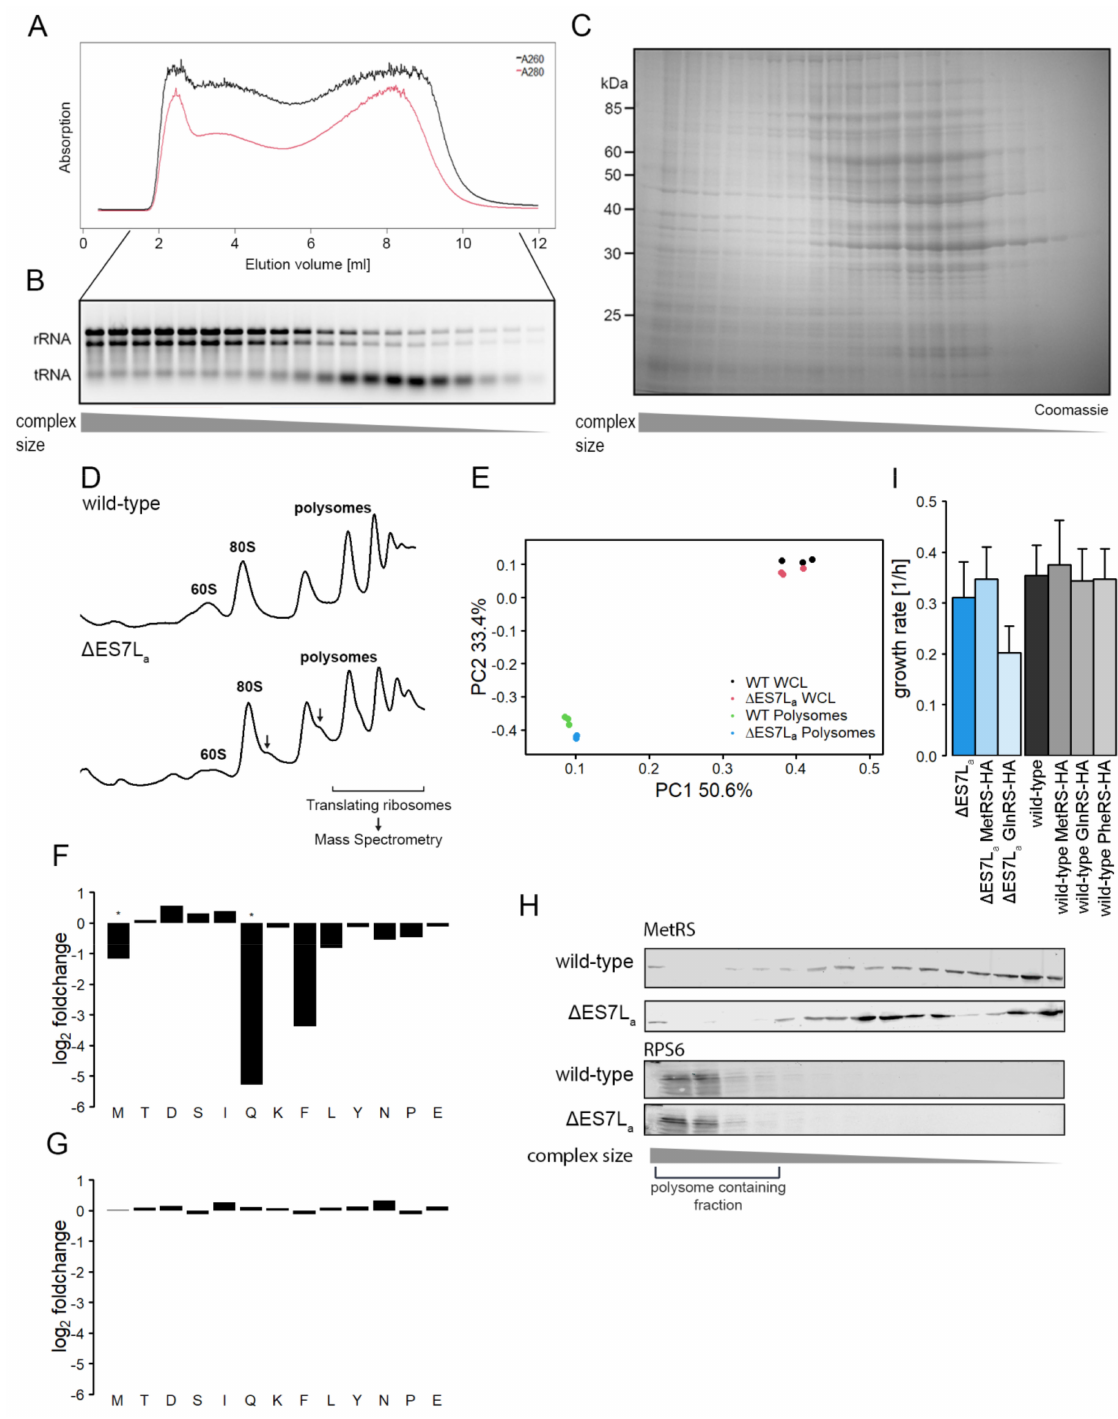
Figure 3. Isolation of actively translating ribosomes and identification of AARS as differential ribosome binders. ( A ) Absorption profiles of size exclusion chromatography (Sepharose 4b column, polysome buffer) as an additional purification step of translating ribosome complexes. Protein and RNA content was measured by A 260 nm (black) and A 280 nm (red) measurement. ( B ) Total RNA isolated from fractions of SEC in A and visualized on a 1% agarose gel. ( C ) Proteins isolated from fractions of SEC via TCA precipitation of fractions in ( A ) and visualized on a 10% SDS-PAGE. ( D ) Application of the purification method for wild-type and ∆ ES7L a samples to isolate translating ribosomes for MS analysis by SEC of the WCL and subsequent density gradient centrifugation. Polysome profiles are shown for one of three replicates each and “halfmer” polysomes occurring in ∆ ES7L a lysates are marked with an arrow. ( E ) LFQ quantified protein intensities between samples were compared using principal component analysis. Similarity between samples is indicated as